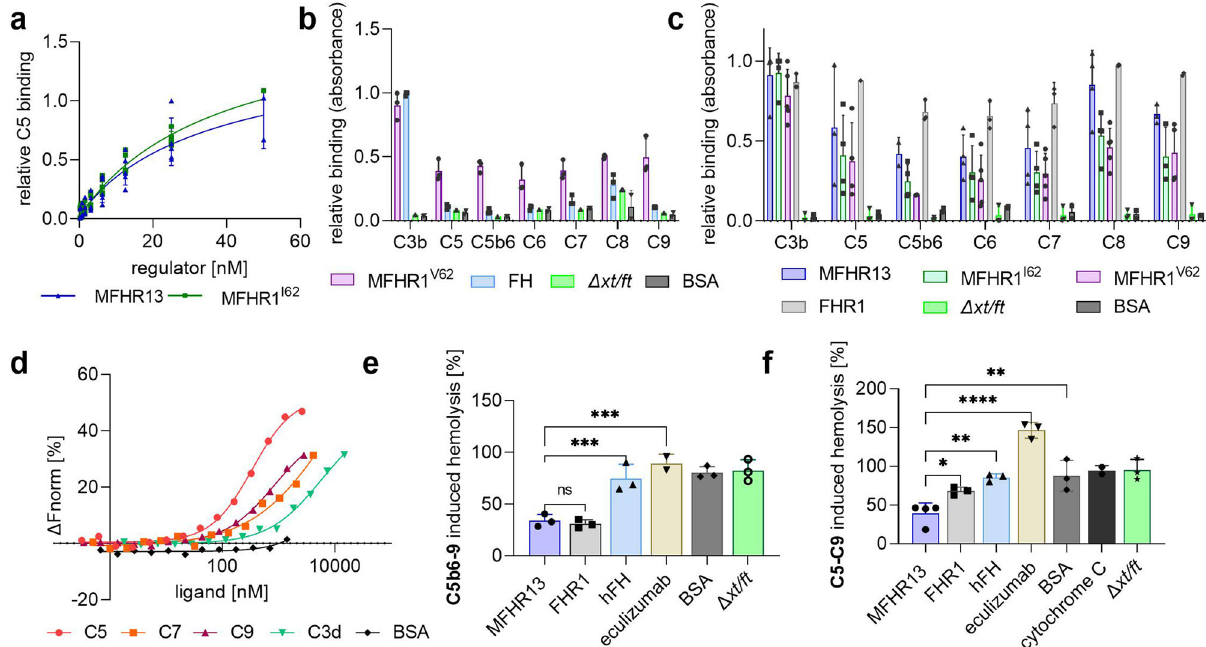
Fig. 7 MFHR13 binds C5 and MAC components and blocks the terminal pathway. a C5 binding was measured by ELISA. Nonlinear regression using the sigmoidal equation and comparison of IC 50 showed similar binding pro fi les for MFHR13 and MFHR1 I62 to C5 ( P = 0.2565). Data represent mean values ± SD from 4 or 5 independent experiments. Absorbance values from one representative experiment are shown in Supplementary Fig. 8c. b MFHR1 binds to the individual TCC proteins; hFH does not. MFHR1 or hFH (25 nM) as well as the negative controls BSA and the puri fi ed extract from the parental line ( Δ xt/ft ) were added to immobilized complement proteins in microtiter plates and detected by anti-FH polyclonal antibodies. Data represent mean values ± SD from 3 independent experiments. c MFHR13, MFHR1, and FHR1 bind to the terminal complement proteins involved in MAC formation. Regulators (25 or 50 nM) were added to immobilized terminal complement proteins and bound proteins were detected by anti-His-tag antibodies. Data represent mean values ± SD from 3 or 4 independent experiments. Absorbance values from one representative experiment from ( b ) and ( c ) are shown in Supplementary Fig. 9. d Binding of NT-647 RED-NHS-labeled MFHR13 to C3d, C5, C7, and C9 was evaluated by Microscale Thermophoresis (MST) in fl uid phase. Normalized fl uorescence ( Δ Fnorm) was plotted against the concentration of single complement components. e MFHR13 and FHR1 inhibit the formation of the MAC on sheep erythrocytes. The inhibition by MFHR13 and FHR1 was signi fi cantly better than hFH ( P = 0.0018), eculizumab ( P < 0.0001), BSA ( P = 0.0012), or Δ xt/ft . Hemolysis of sheep erythrocytes was induced with addition of C5b6, C7, C8, and C9 and release of hemoglobin was determined by measuring the absorbance at 405 nm. The average absorbance values without C5b6 and without C9 were subtracted from the positive control and samples. Lysis induced by TCC in absence of regulators was set to 100%. Data represent mean values ± SD from three independent experiments (one-way ANOVA, Bonferroni post hoc test). f MFHR13 (700 nM) inhibits MAC formation on C3b-opsonized sheep erythrocytes signi fi cantly better than FHR1 ( P = 0.0415), hFH ( P = 0.0018), eculizumab ( P < 0.0001), BSA ( P = 0.0012), cytochrome c ( P = 0.0007), and Δ xt/ft . Hemolysis of C3b- coated sheep erythrocytes was induced with a mix of C5-C9 and determined by absorbance of released hemoglobin at 405 nm. Lysis without regulators was set to 100%. The average absorbance values without C5 were subtracted from all samples. Data represent mean values ± SD from three independent experiments (one-way ANOVA, Bonferroni post hoc test). **** P ≤ 0.0001, *** P ≤ 0.001, ** P ≤ 0.01, and * P ≤ 0.05, ns (no signi fi cant